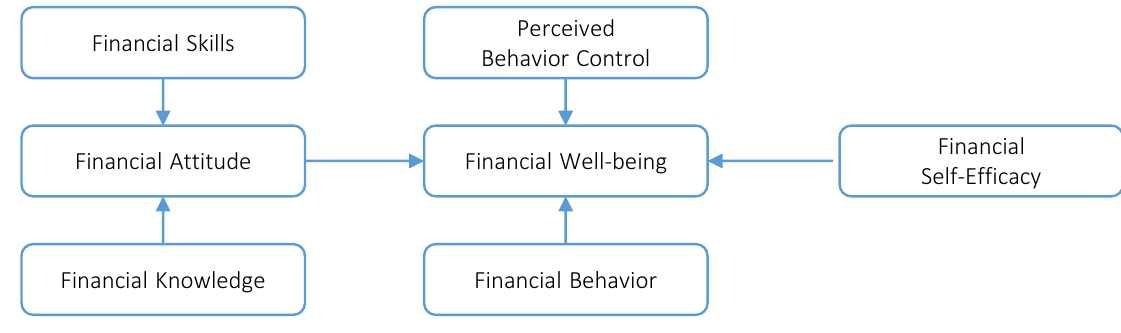
Figure 1. Proposed model of factors affecting financial well-being of Vietnamese